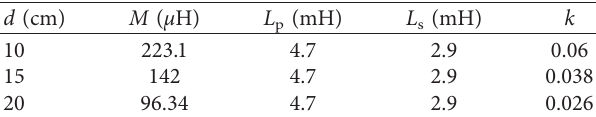
Table 1: Values of mutual inductance for different air gap